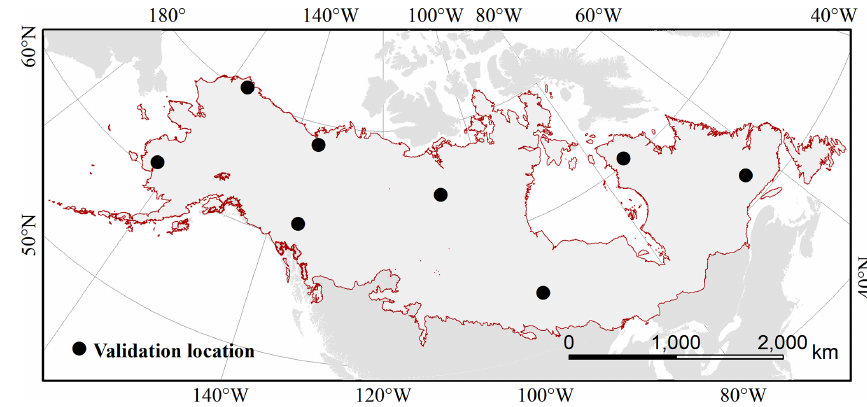
Figure 5. Locations of the five regions selected and interpreted for assessing the accuracy of the indicators of water